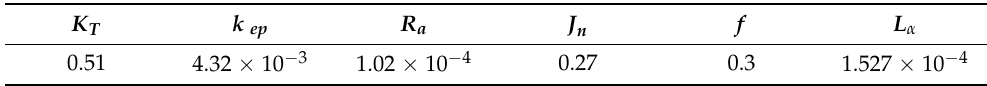
Table 1. Simulation